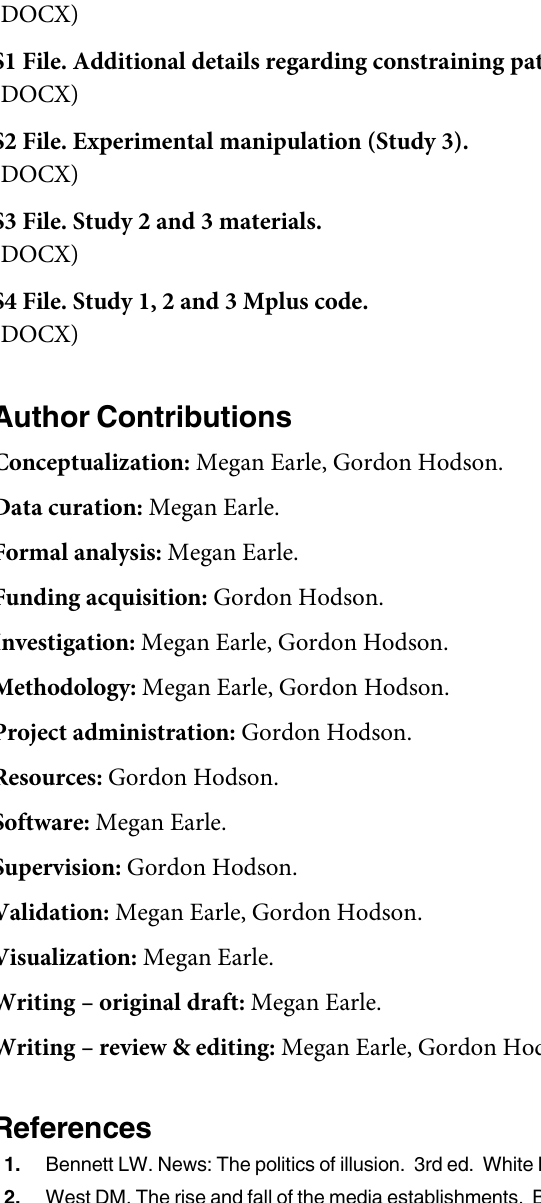
S1 Fig. Experimental effect of left-leaning news and right-leaning news exposure on social attitudes (Study 3). S1 Table. W1-W2 and W2-W3 autoregressive paths from cross-lagged